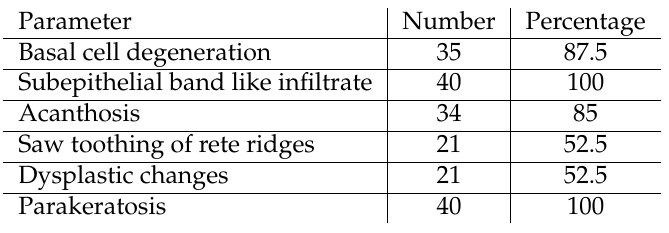
Table 6. Histological findings in our patients of oral LP Parameter